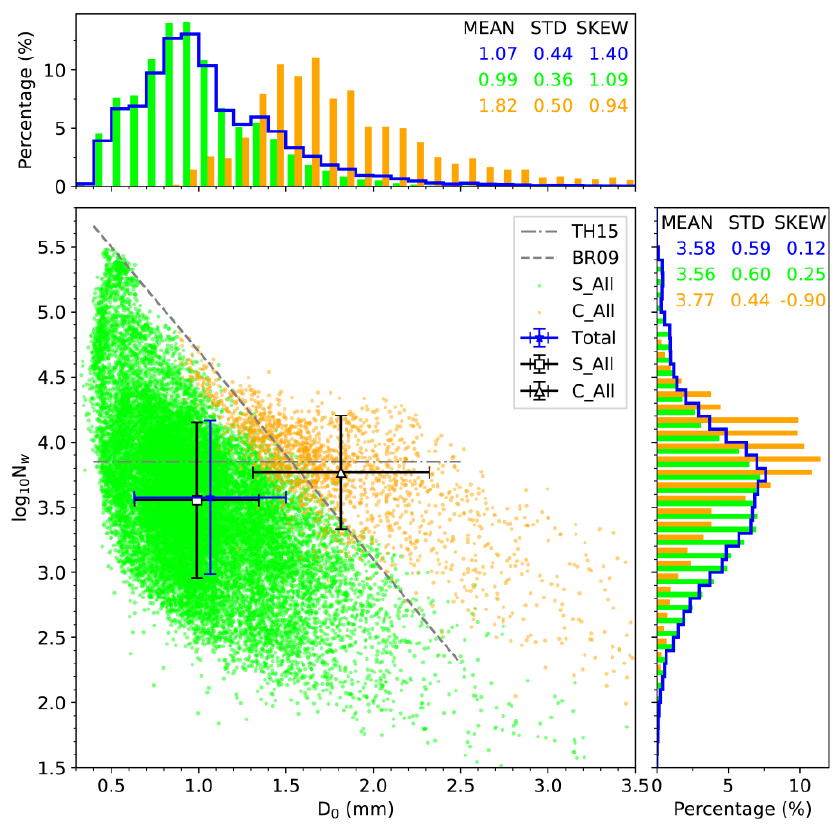
Figure S1. As in Figure 4, but for the TE01 classification scheme.